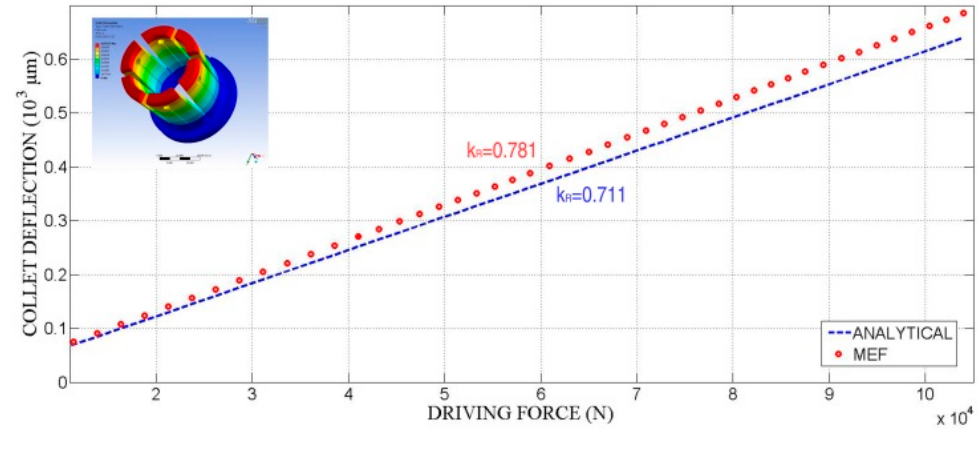
Figure 17. Collet deflections: analytical and finite element